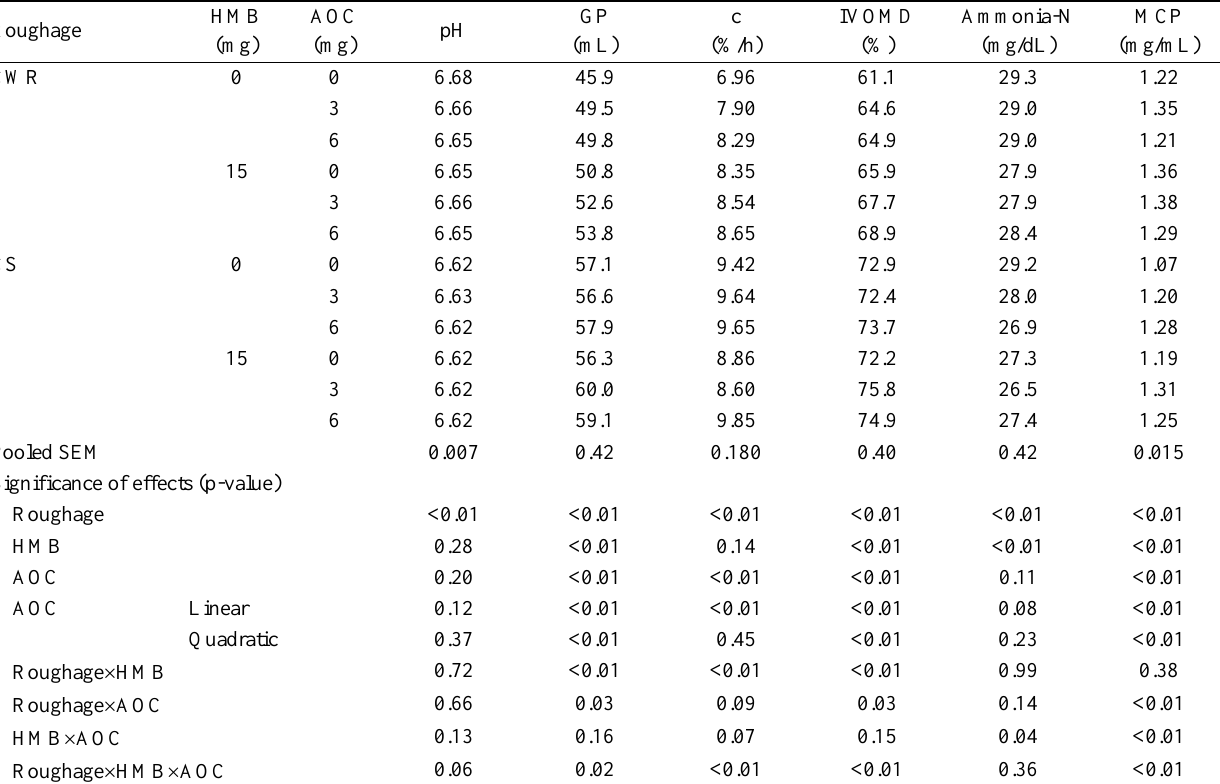
Table 4. Effects of AOC and HMB on in vitro GP and MCP at 24 h incubation for different roughage sources HMB Roughage